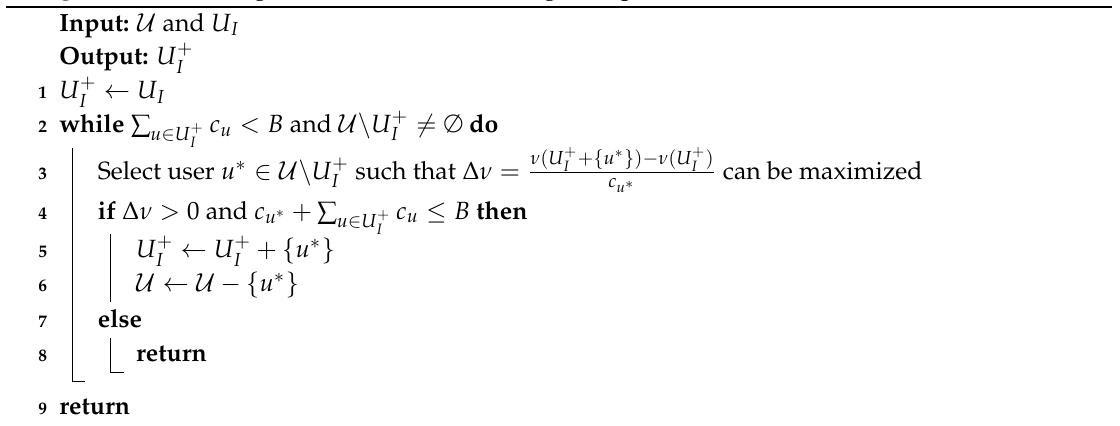
Algorithm 2: Adding Users in the Case of Budget